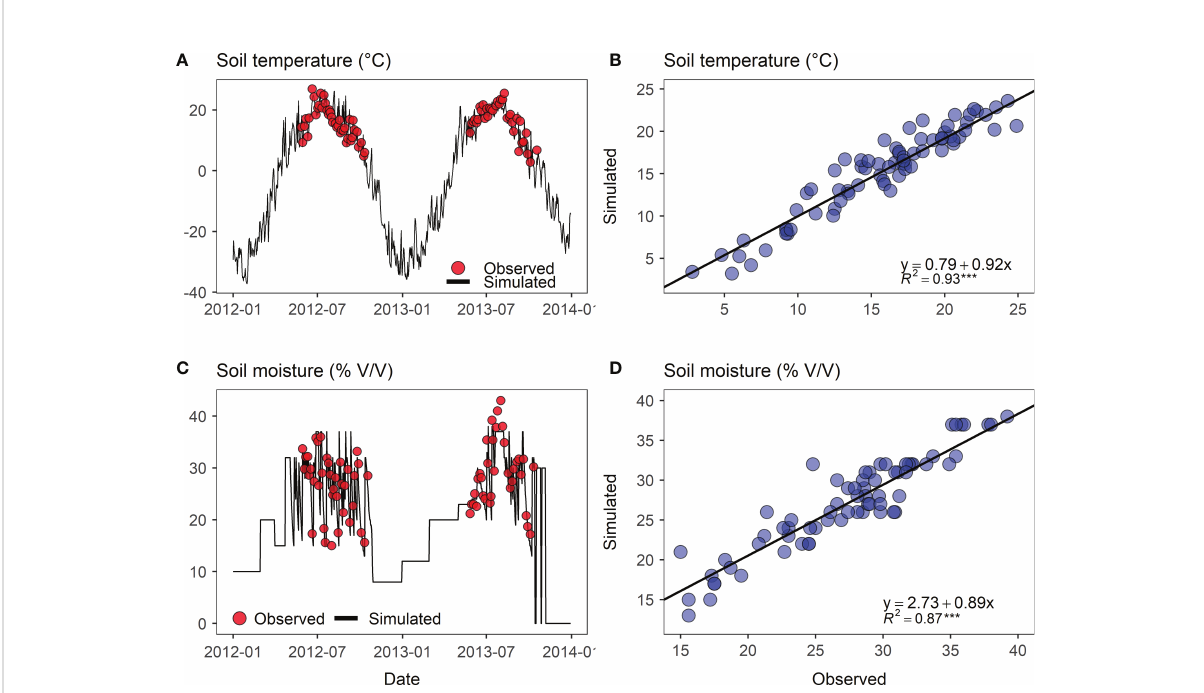
FIGURE 3 Relationship between the simulated versus observed soil temperature (0-10 cm) and soil moisture (0-10 cm) of the sown alfalfa pasture fi eld at the Hulunber site. (A, C) Field observed soil temperature and moisture (red dots) superposed with DNDC-simulations (black curves); (B, D) Scatter plots of observed versus simulated soil temperature and moisture. The solid black line represents the linear trend fi tted to the simulated versus the observed data. ***p <